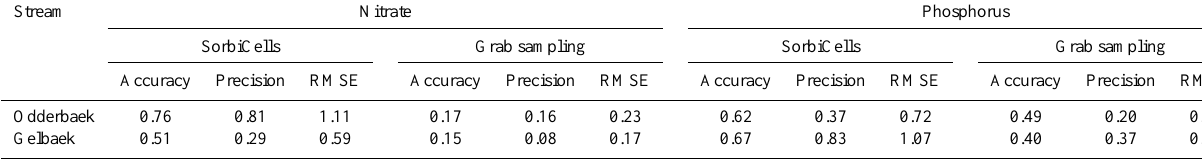
Table 2. Accuracy (mean relative error), precision (standard deviation of the relative error) and root-mean-squared error (RMSE) of Sorbi- Cells passive samplers and grab sampling compared to time-proportional sampling for monitoring nitrate and phosphorus in streams. Stream